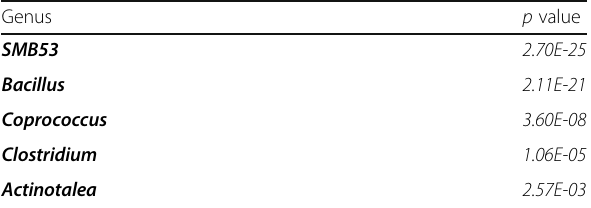
Table 2 Genera distinctly high in the Wild High (lean) group, discovered using two-way ANOVA and False Discovery Rate